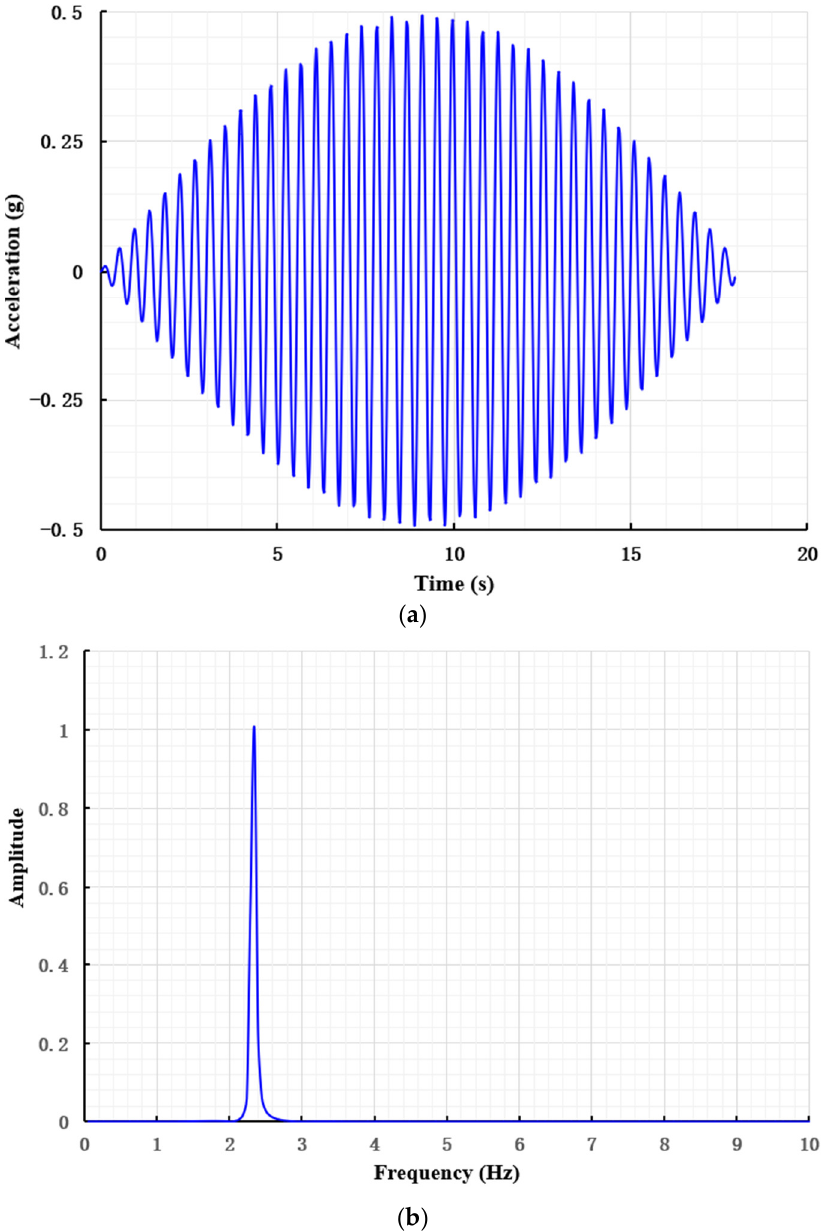
Figure 4. Frequency domain response of sine wave acceleration amplitude and loading signal. ( a ) Acceleration amplitude of loading signal (prototype). ( b ) Frequency domain response of normalized loading signal (prototype).